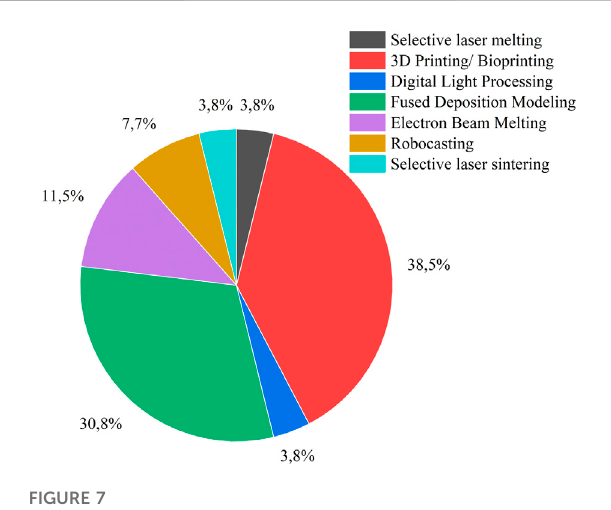
FIGURE 7 The mandibular implant fabrication